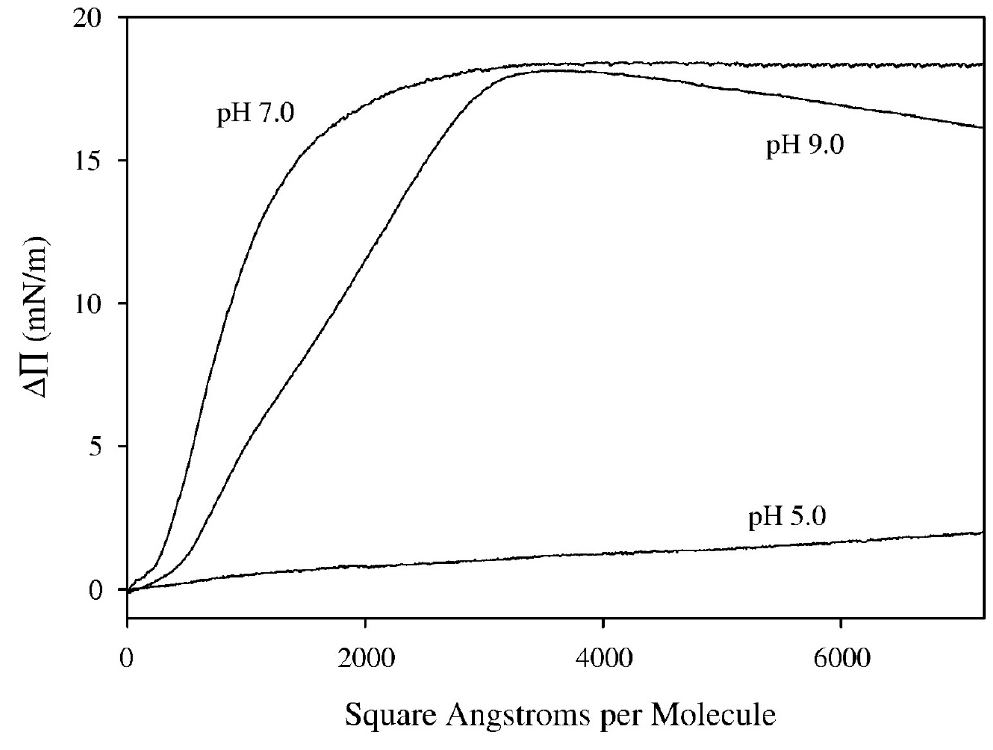
Figure 8. Surface pressure response ( Δ Π ) vs. time for mixed monolayers of dimyristoylphosphatidylcholine (DMPC) and cholesterol of 7:3 mole ratio interacting with 1 μ M tomatine compared on 0.05 M subphases of pH 5.0 (acetate buffer), pH 7.0 (phosphate buffer), and pH 9.0 (borate buffer). The monolayers were compressed to 10 mN m − 1 prior to injection. Each subphase contains 0.10 M NaCl. Reproduced with permission from reference [82].